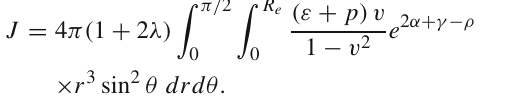
two plots we can note that for the EoS IU–FSU we can reach higher maximum central energy density than for EoS